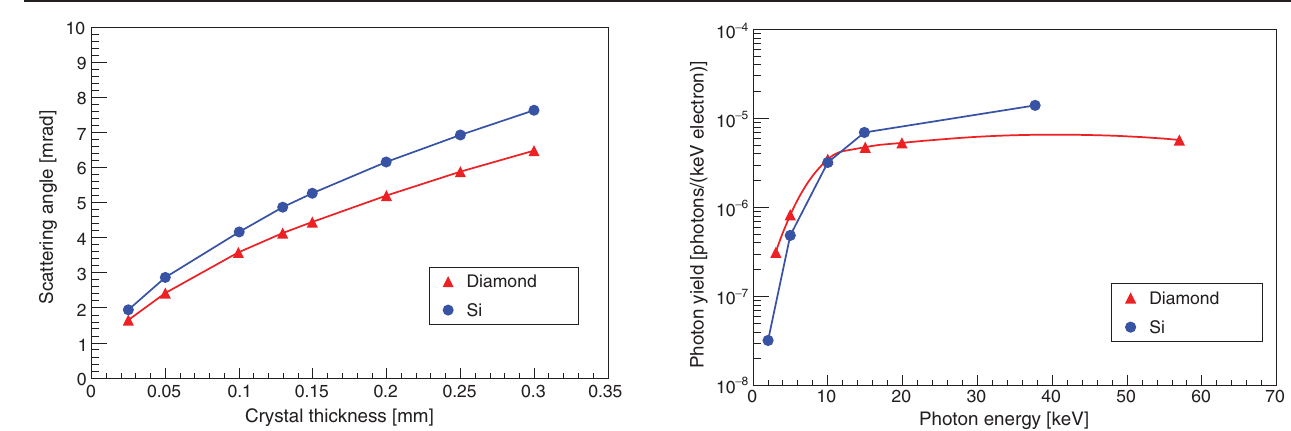
FIG. 9. The dependence of PXR yield on the x-ray energy for Si and diamond with the Miller index (111).